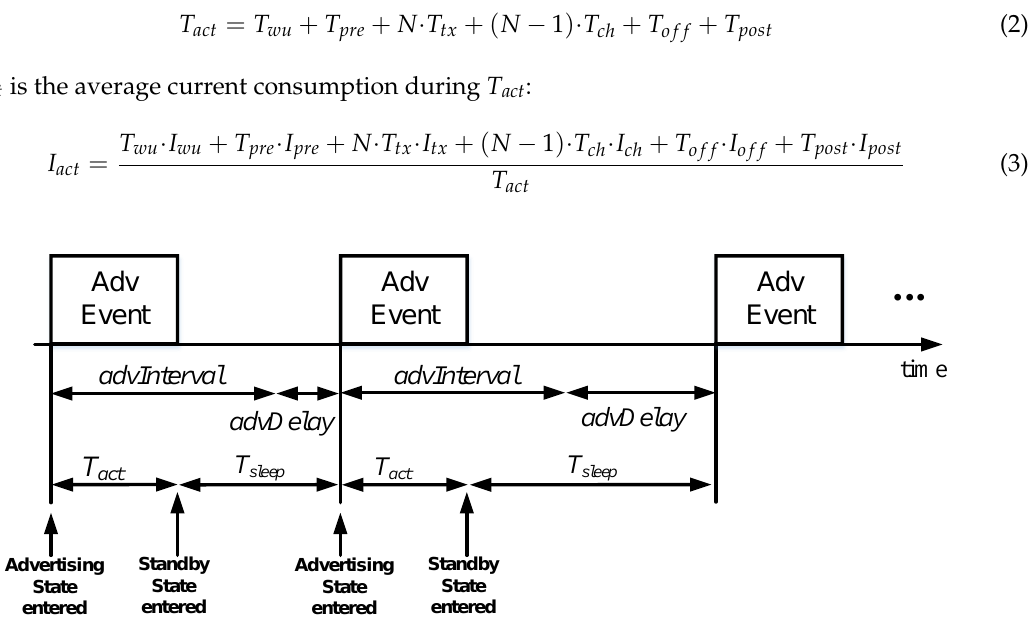
Figure 5. Illustration of variables involved in the calculation of the average current consumption in the advertisement-based approach ( I avg_adv ). ‘Adv Event’ refers to an advertising event.